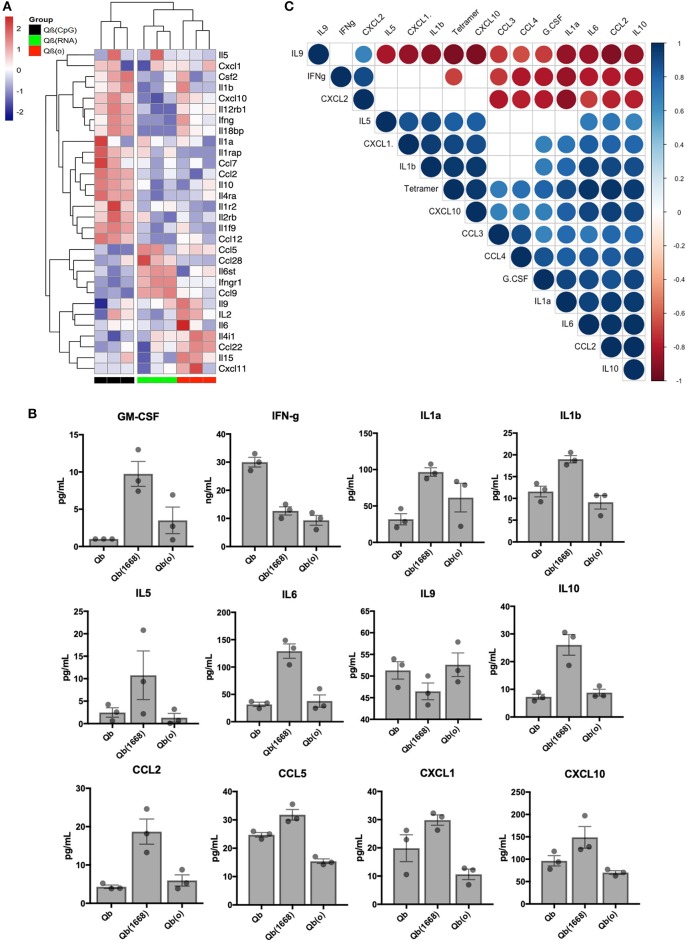
Immunization with the different VLPs leads to distinct Cytokines production. (A) Expression data (multi mapped counts per million) of selected cytokines 24 h post immunization in splenic DCs (+12 h incubation). Hierarchical clustering of top 30 differently expressed cytokines. Clustering calculated based on the Euclidean distances using complete linkage clustering. (B) Secreted cytokines by splenocytes 24 h post immunization. Values represented as mean + SEM. N = 3 mice. (C) Correlation matrix of cytokines secreted by splenocytes 24 h post immunization. Positive correlations are displayed in blue and negative correlations in red color. Color intensity and the size of the circle are proportional to the correlation coefficients. Legend colors shows the correlation coefficients and the corresponding colors. Correlation calculated using Pearsons coefficient. Correlations with significance p > 0.01 are depicted in white.